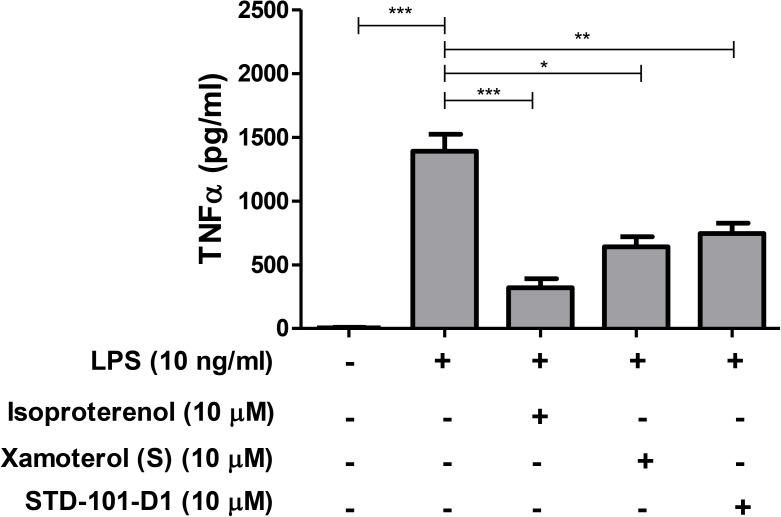
Inhibitory effects of ADRB1 ligands on LPS-induced TNFα response in primary microglia.Data are represented as mean ± S.E.M.s of four independent experiments (n = 3–18 per group, * p < 0.05, **p < 0.01, *** p < 0.001, one-way ANOVA followed by Dunnett’s multiple comparison against LPS exposure alone).